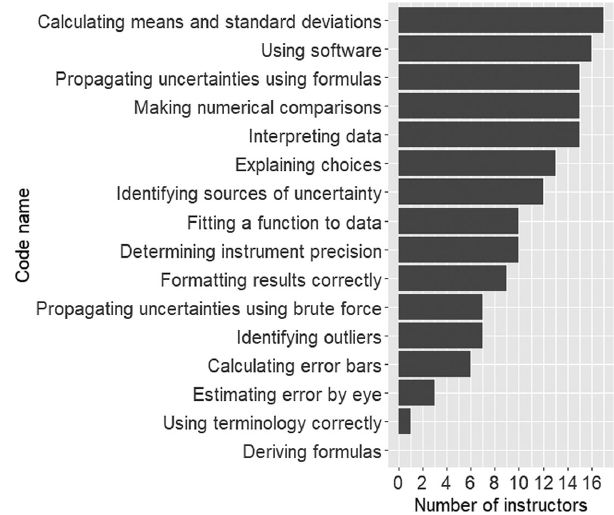
¼ 22 ) in which in- tot